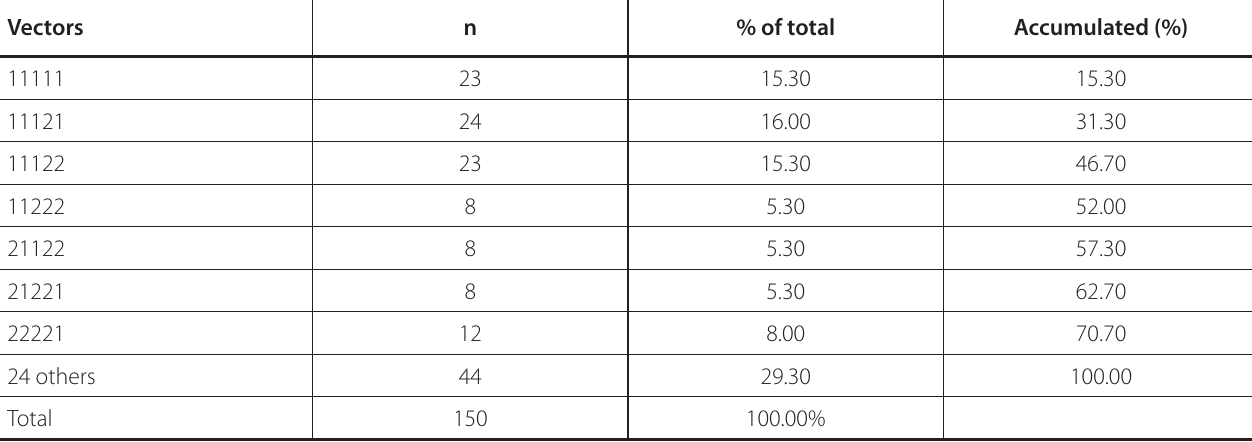
Table 2 . Frequency of EQ-5D health status of patients without pacemaker.